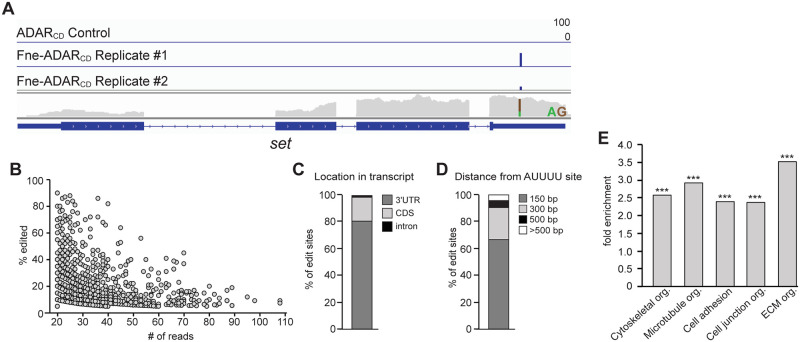
TRIBE analysis in Drosophila S2 cells identifies Fne target transcripts.(A) A sample gene, set, showing edits detected in control cells expressing ADARCD and in two biological replicates from cells expressing Fne-ADARCD. mRNA expression level is shown below the edit tracks. Editing events are indicated by the blue bars, with the height of the bar representing the editing percentage for a given site. The editing percentage is a measure of the number of times a site was edited relative to its total read count. For editing events, thresholds of 5% editing and 20 reads were applied. (B) Editing percentage shown as a function of the number of reads at a given site, indicating no relationship between editing frequency and transcript abundance. (C) Quantification of the frequency of edited sites in the indicated transcript locations. (D) Quantification of the proximity of edited sites to an AUUUU motif. (E) Quantification of the overrepresentation of certain GO terms in targets obtained for Fne. ***p<0.001 as determined by Fisher’s exact test.